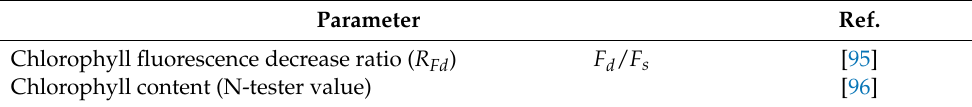
Table 7. Photochemical quenching parameters. Parameter